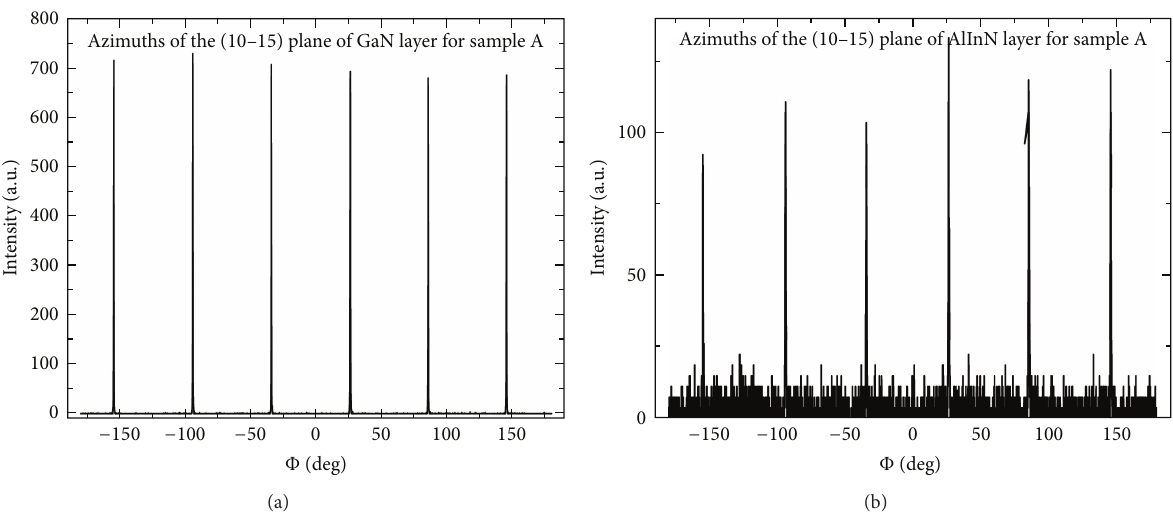
Figure 4: Phi scan curve of asymmetric (10–15) reflection plane of the (a) GaN and (b) AlInN for sample A. Every peak shows azimuths of the (10–15) plane. The diffractive peak repeats every ∼ 60 ∘ .